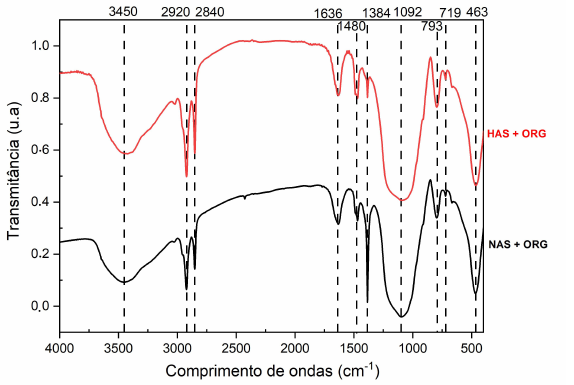
Figure 8. FTIR Spectrum of organophilized synthetic clays using the semi-dry methods for NAS and